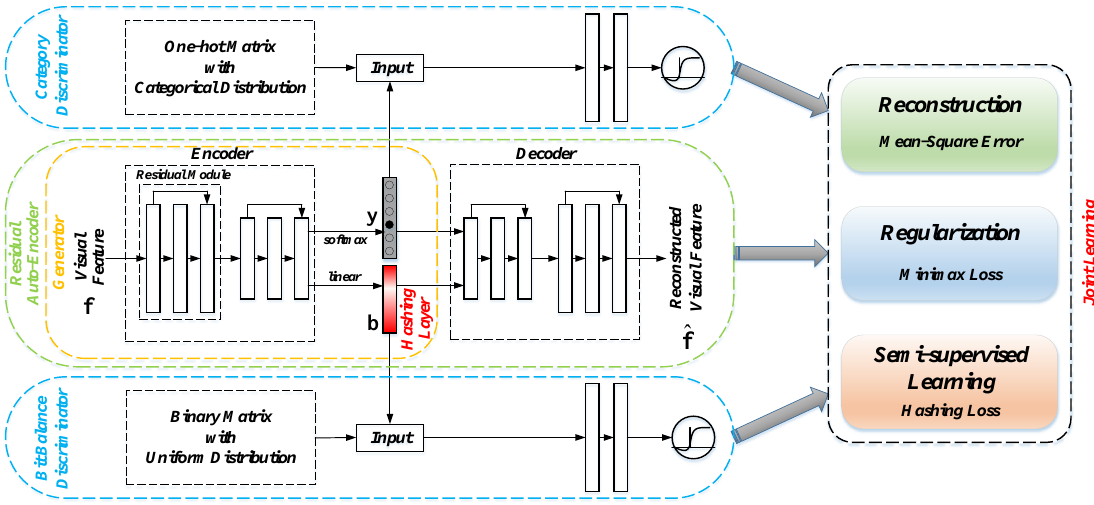
Figure 3. Framework of the proposed semi-supervised deep adversarial hashing